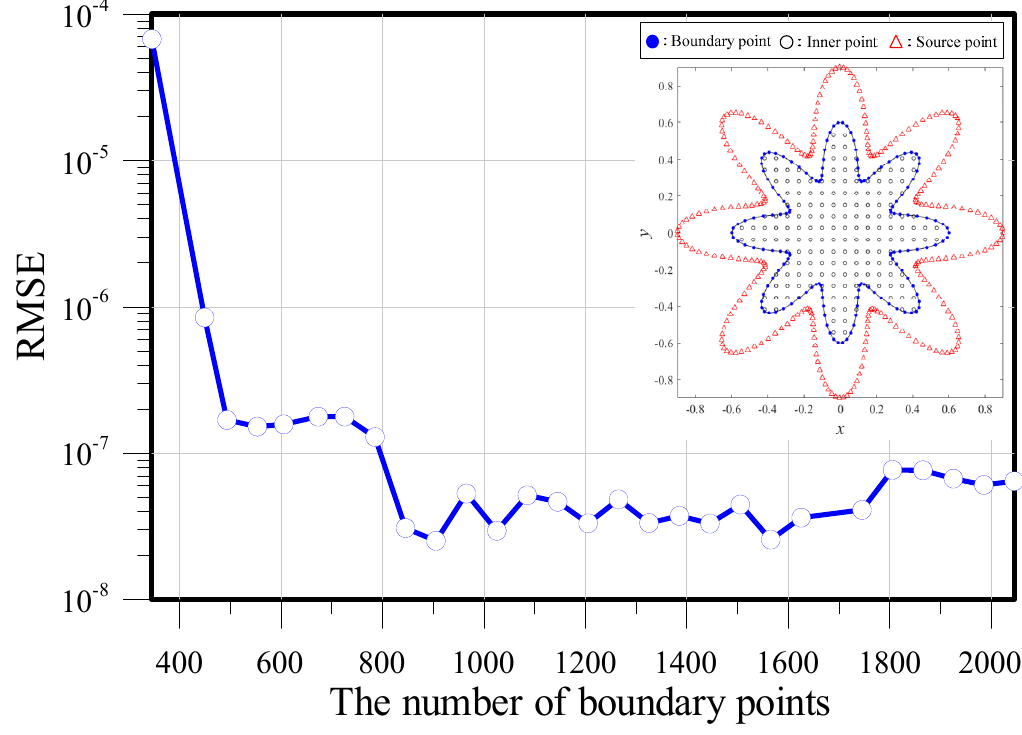
Figure 15. Boundary point number versus RMSE.